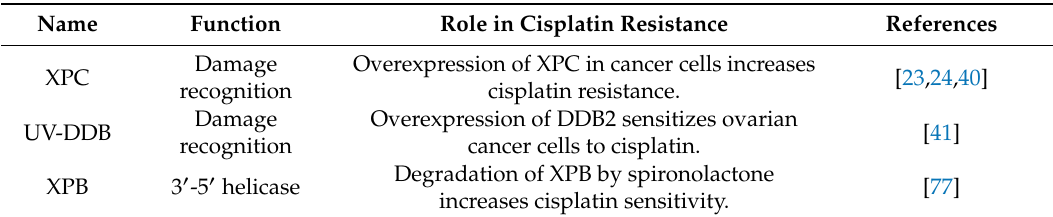
Table 1. NER factors with known functions in cisplatin